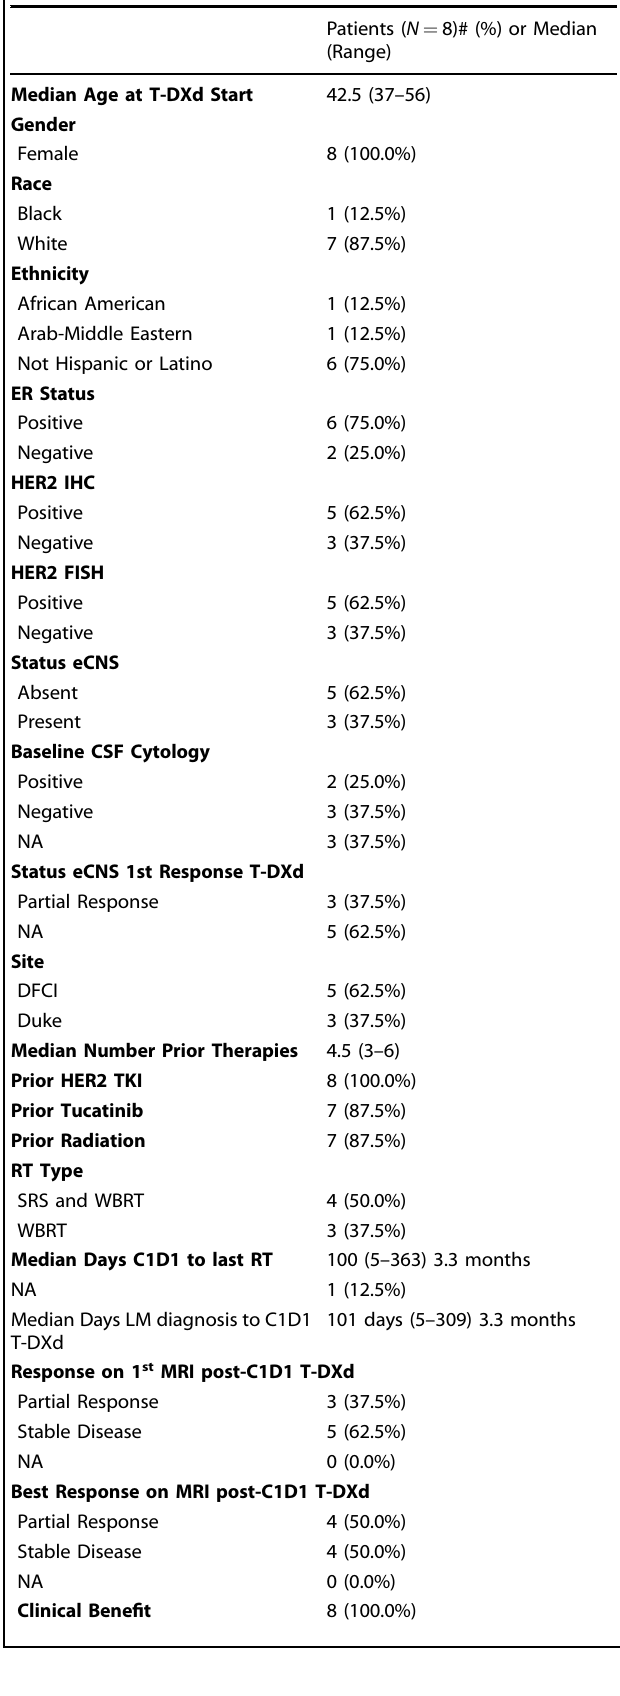
Table 1. Demographic Characteristics and Clinical